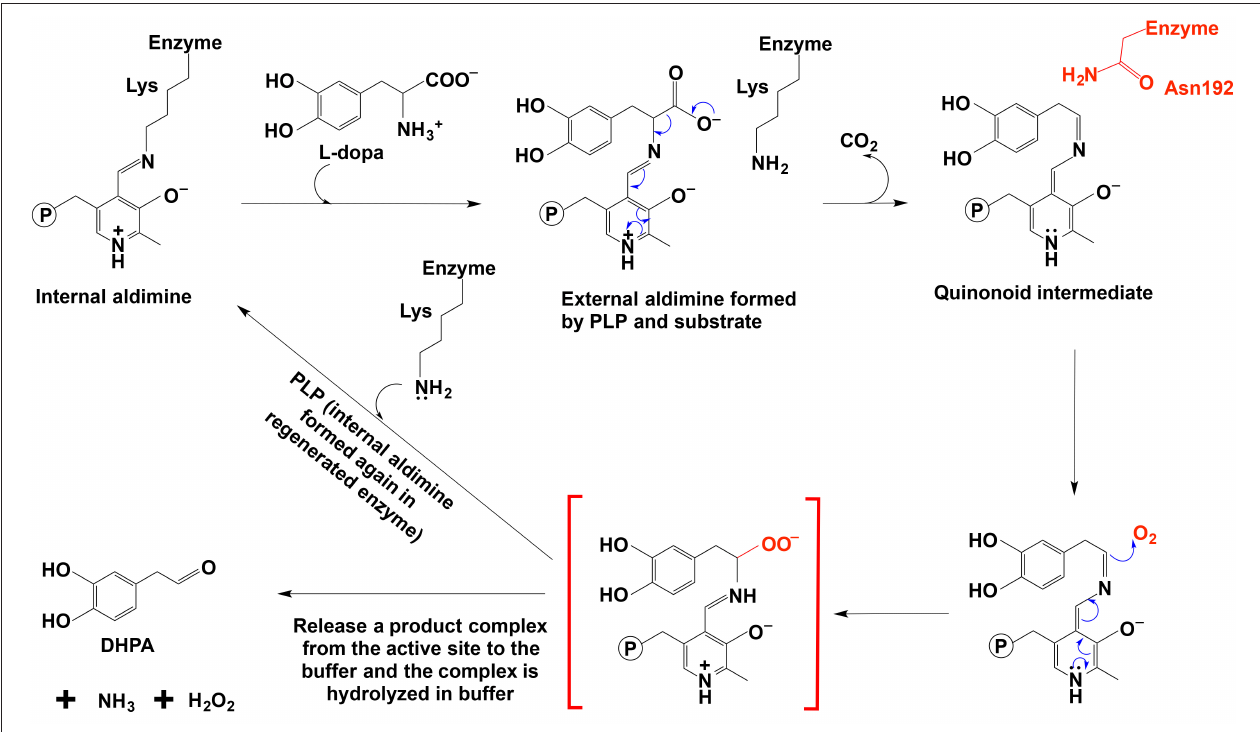
FIGURE 8 | The mechanistic role of Asn192 residue in Drosophila melanogaster DHPA synthase (Liang et al.,